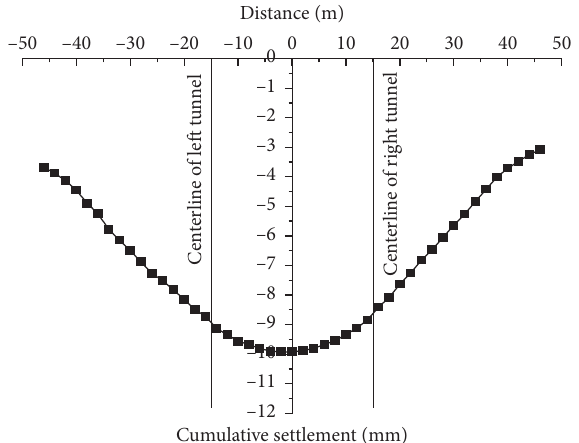
Figure 11: Cumulative settlement of right-line tunnel